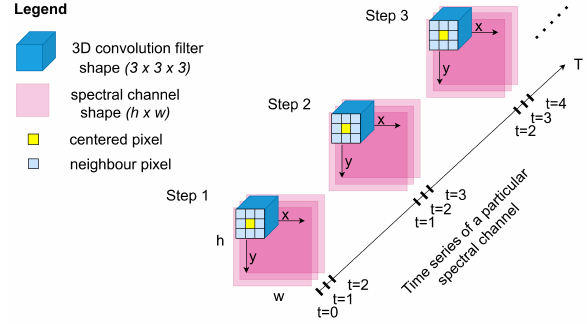
Figure 4. Representation of a 3D convolution on a spectral channel. Only the three first sliding steps are